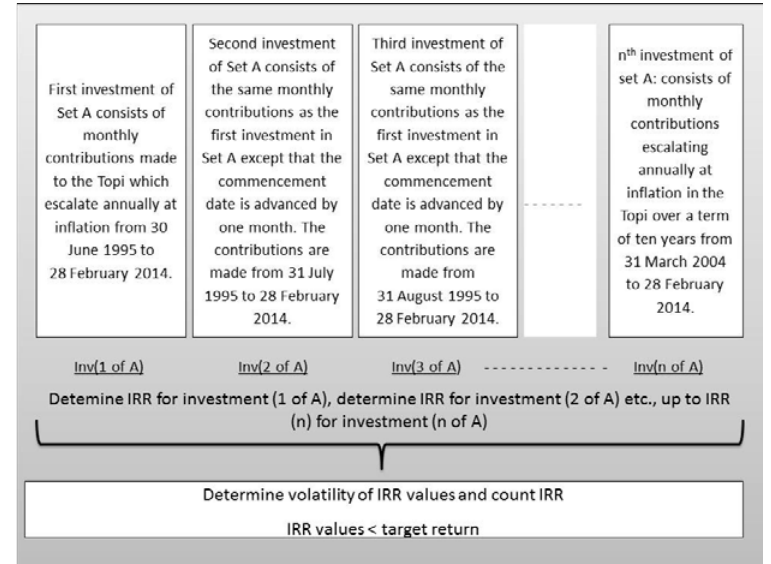
FIGURE 2: Example of the volatility analysis of simulated investments of Set A Source: Authors’